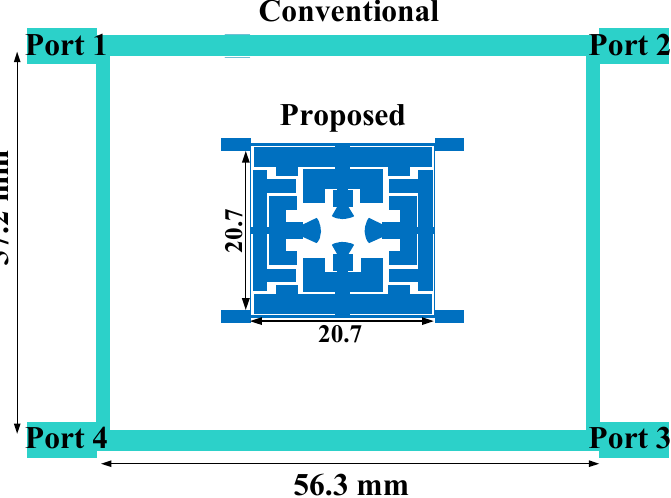
Figure 13. Structure of the proposed and the conventional BLCs.